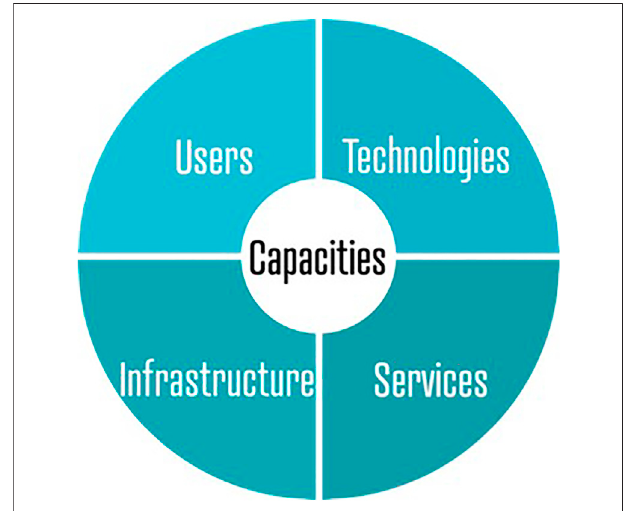
FIGURE 2 | Safe system approach for net-zero